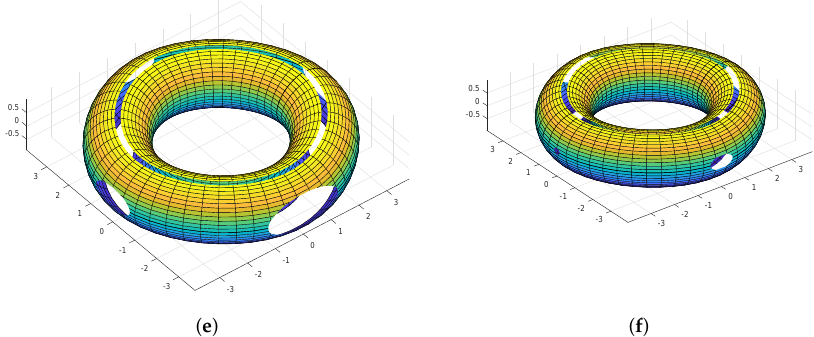
Figure 4. ( a ) The results of the NURBS; and ( b – f ) the deformation of a surface made of NURBS